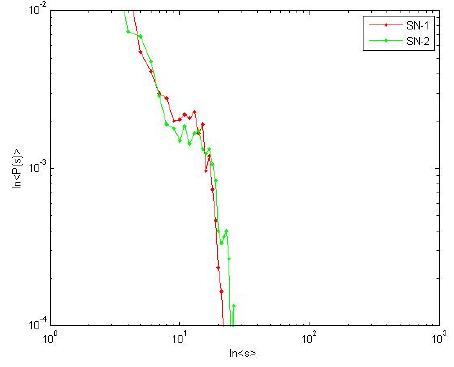
Figure 16. Avalanche size in critical state.